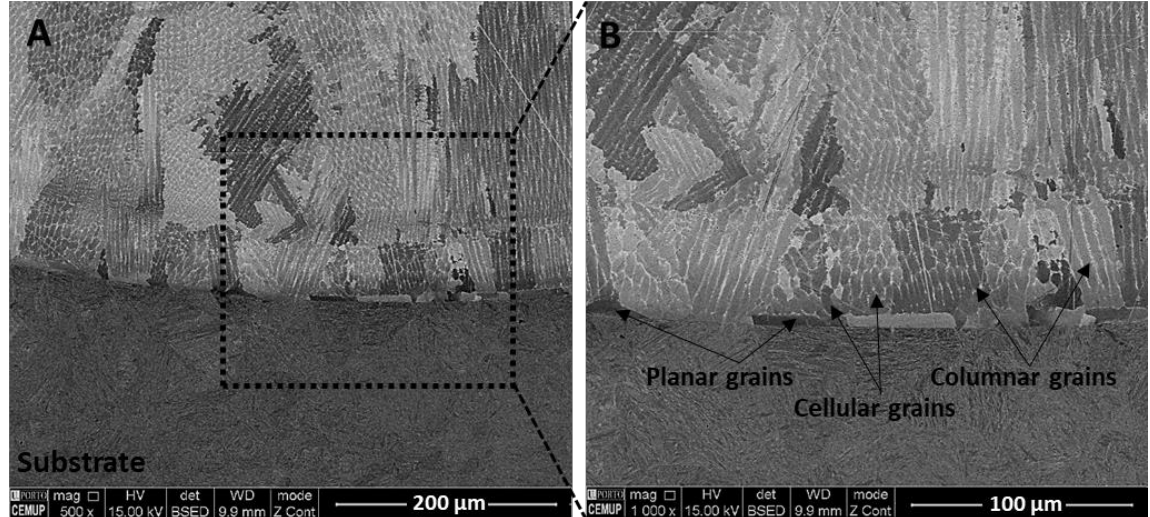
Figure 6. Microstructure of cladding produced by the I2_6_20 cladding condition on the preheated substrate, showing ( A ) substrate interface cladding zone. ( B ) A higher magnification illustration of the interface.